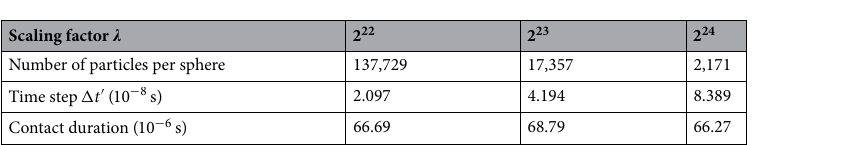
Table 2. Test conditions and the contact durations of the sphere collision. As the system is renormalized, the number of particles are reduced and the time step is increased accordingly to the scale transformation rule, whereas the contact durations remain relatively the same.